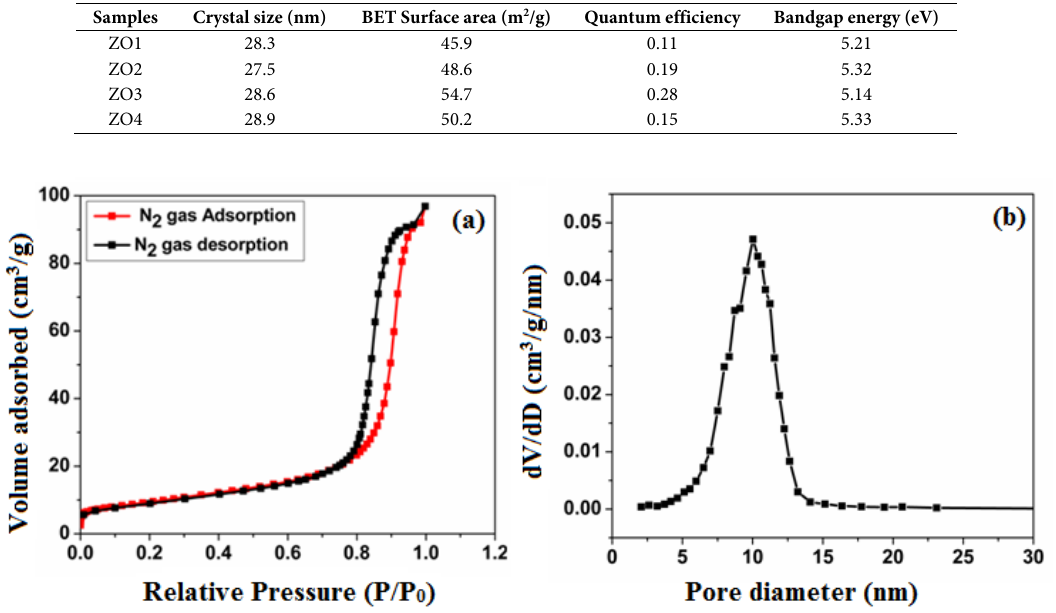
Fig. 5. (a) the BET surface area and (b) the N